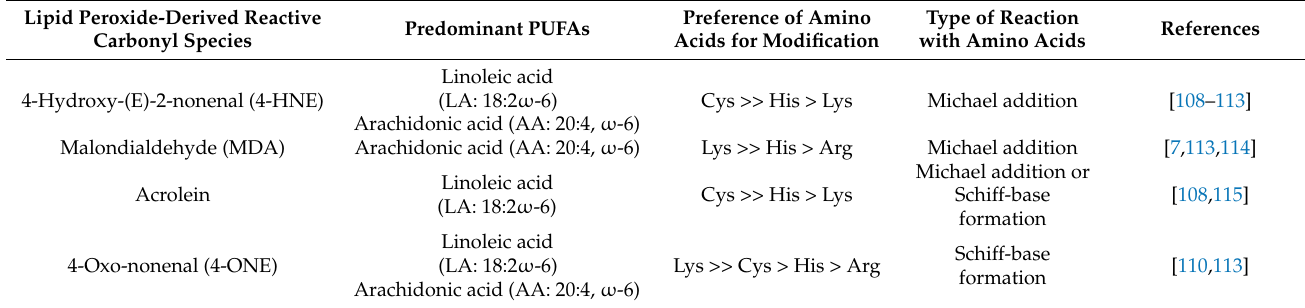
Table 1. Reactive carbonyl species (RCS) frequently implicated in protein carbonylation-mediated gene signaling. Lipid Peroxide-Derived Reactive Preference of Amino Type of Reaction Predominant PUFAs Carbonyl Species Acids for Modification with Amino